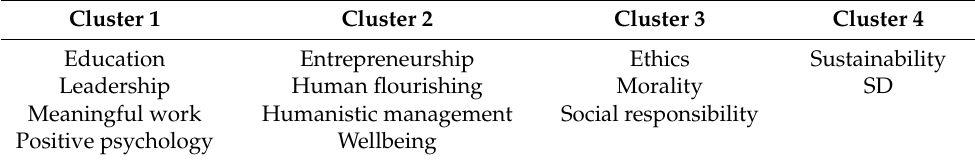
Table 14. Clusters related to HF as a keyword (SCOPUS